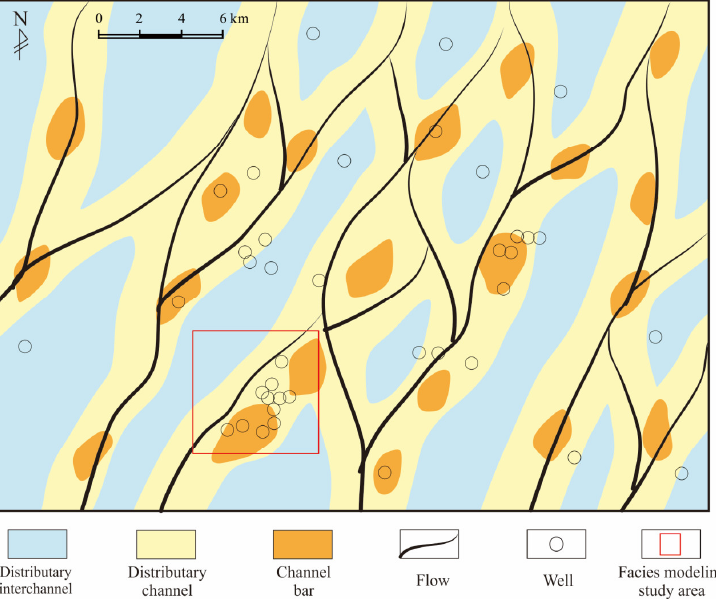
Figure 3. Distribution of plane sedimentary facies of P 2 h 8 member in Ct3 study area.